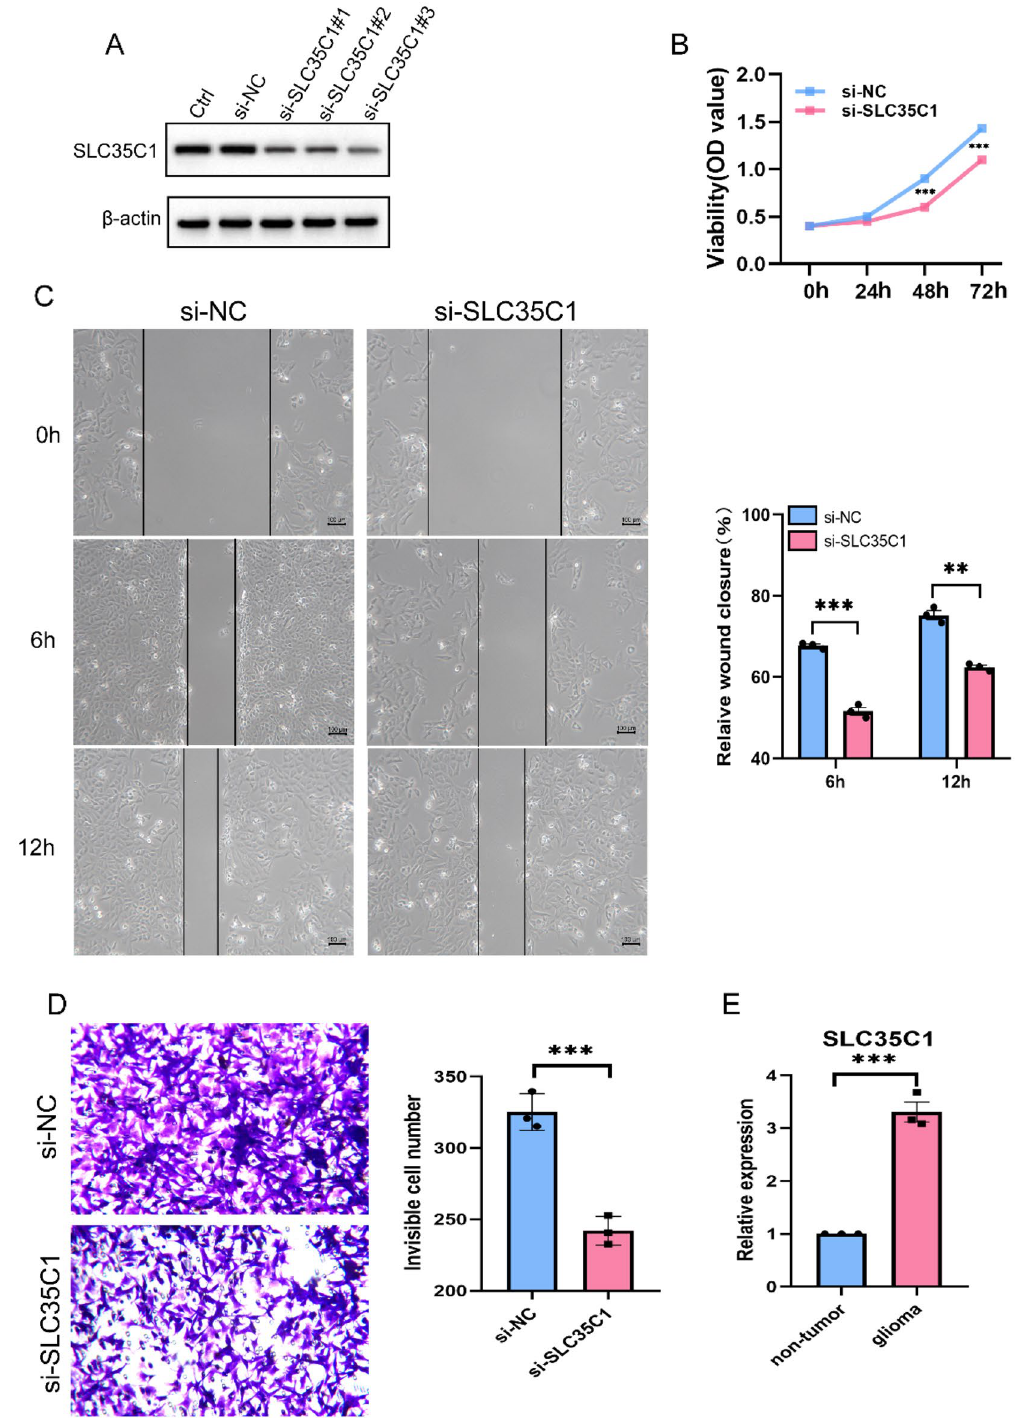
Figure 12. Knockdown of SLC35C1 inhibits the proliferation, migration and invasion capacities of glioma cells in vitro. ( A ) Western blot analysis of transfection efficiency of the siRNA. original blots/gels are presented in Supplementary Fig. 6 ( B ) Cell proliferation was detected by using the CCK8 proliferation reagent. ( C ) Effect of SLC35C1 knockdown in cell migration was determined by wound healing assay and the percentage of scratch- width closure measured by quantifying the images the scratch assay at 0, 6 and 12 h after incubation. ( D ) Invasiveness of glioma cells analyzed by transwell invasion assay (magnification, × 100) and bar graph showing quantitative results of the transwell assay. ( E ) Validations for long non-coding RNAs expressions. Detection of significant differences in the expression levels of SLC35C1-related lncRNA in non-tumor and glioma by qPCR. *P < 0.05; **P < 0.01; ***P <